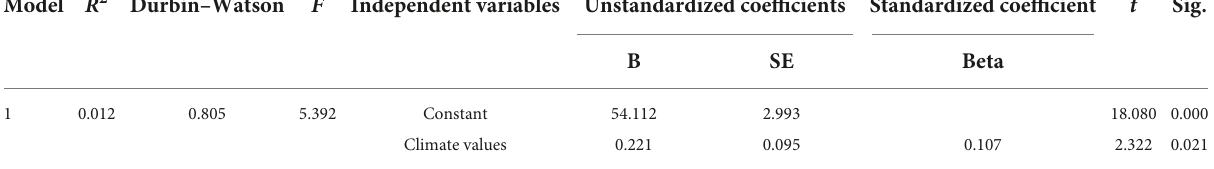
TABLE 11 Results of regression analysis of climate values (CV) on climate change perception (CCP). Model R 2